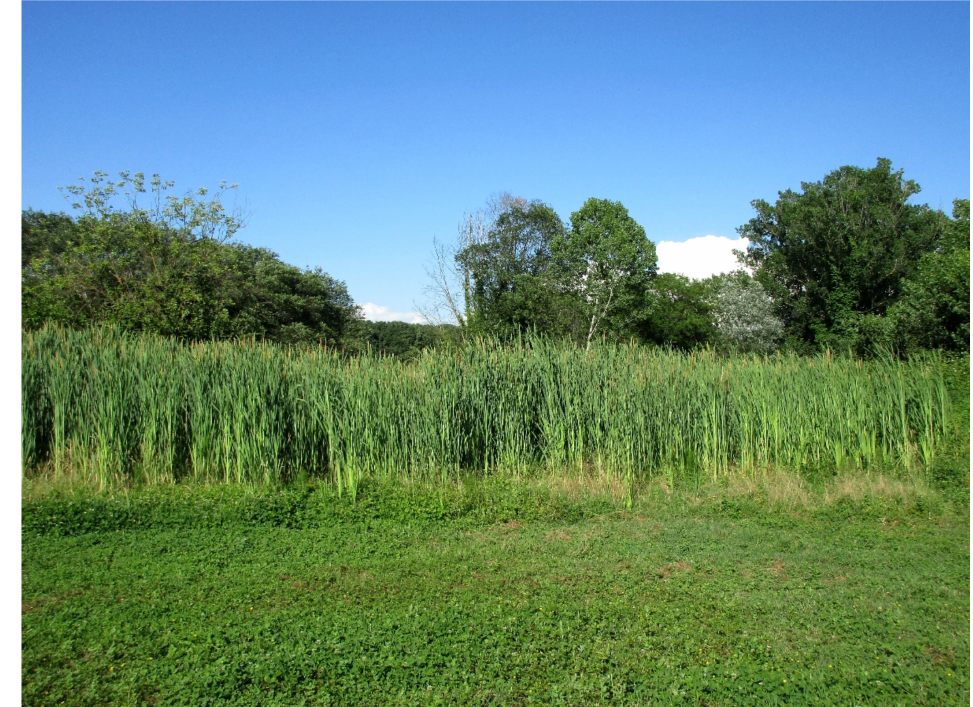
Figure 28. Typha latifolia community (Caffarella